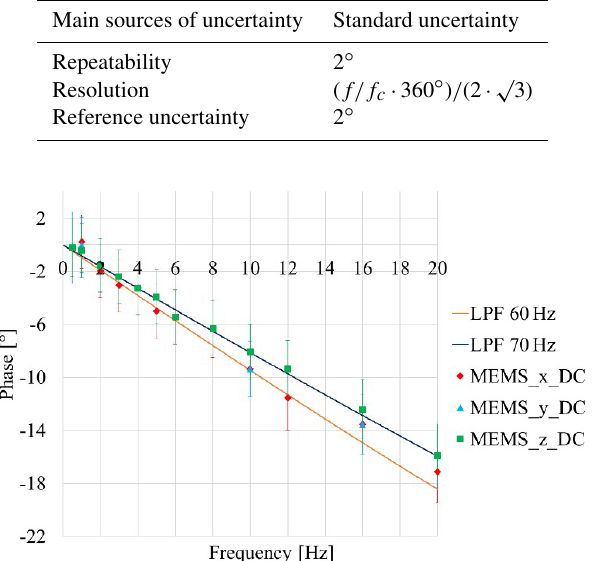
Figure 6. Comparison between phase theoretical curves of first- order low-pass filters (LPFs) with cut-off frequencies 60 and 70Hz and experimental data from the MEMS accelerometer, acquired in DC mode.